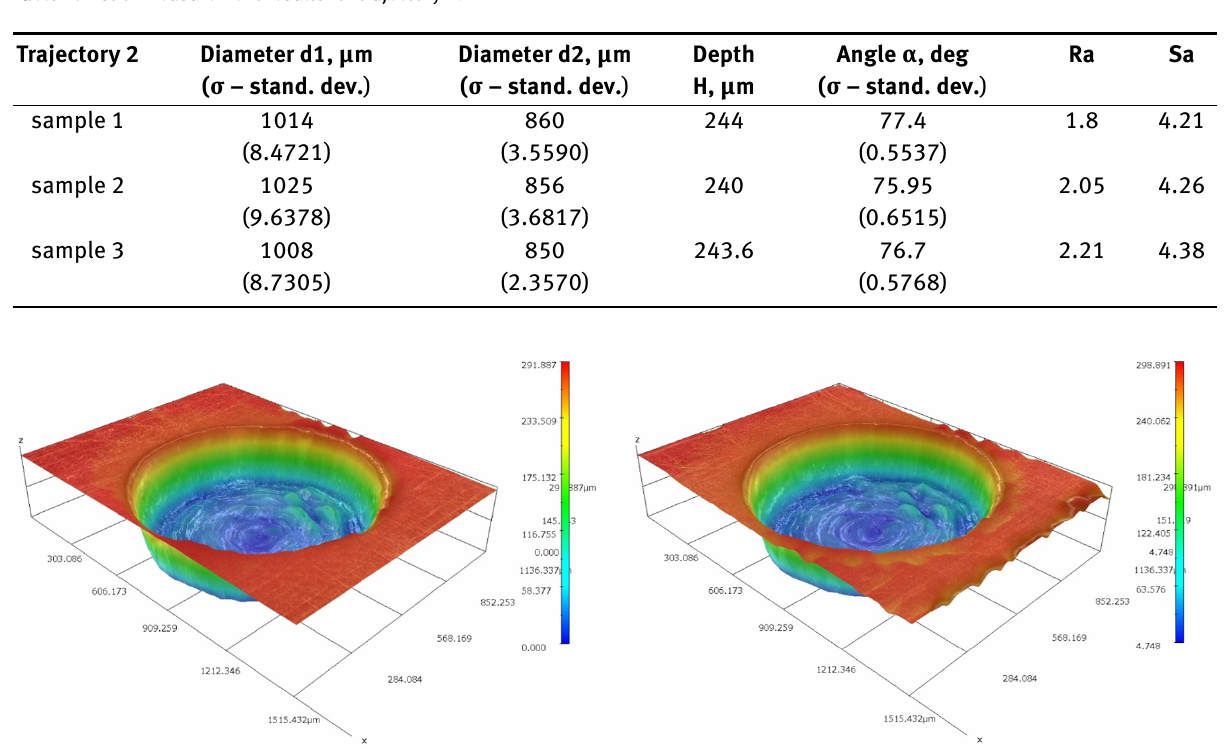
Table 2: List of measurement results for trajectory 2.